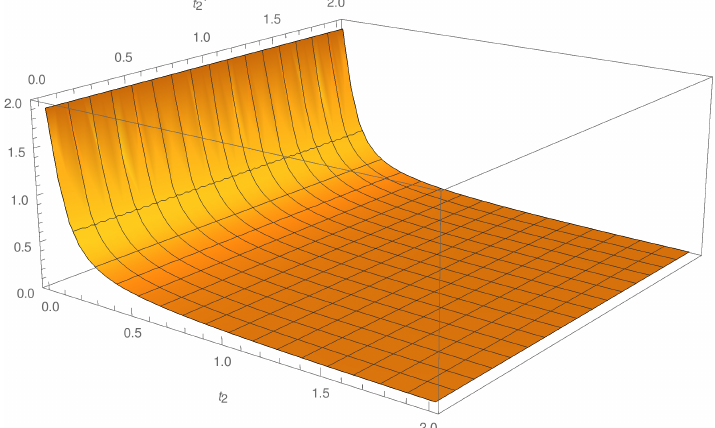
calculated for the EPR state, 2